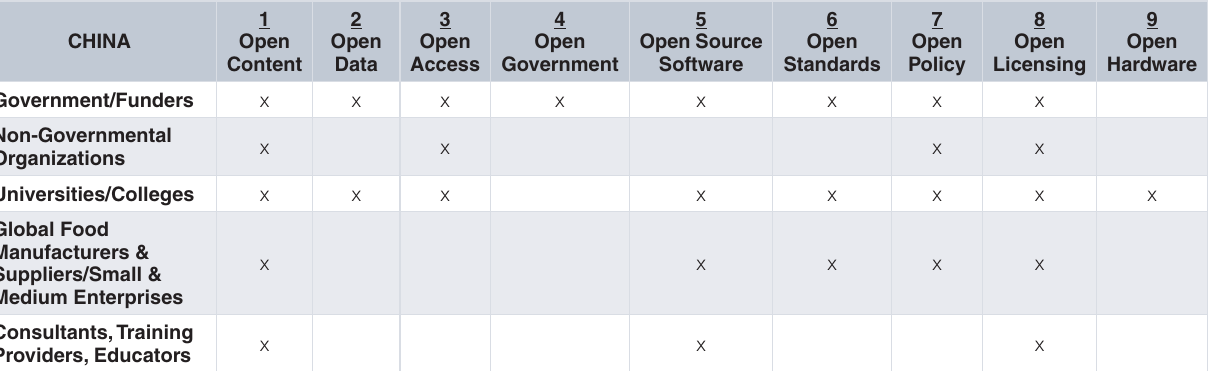
Table 1. Potential starting points for stakeholder use of open practices: